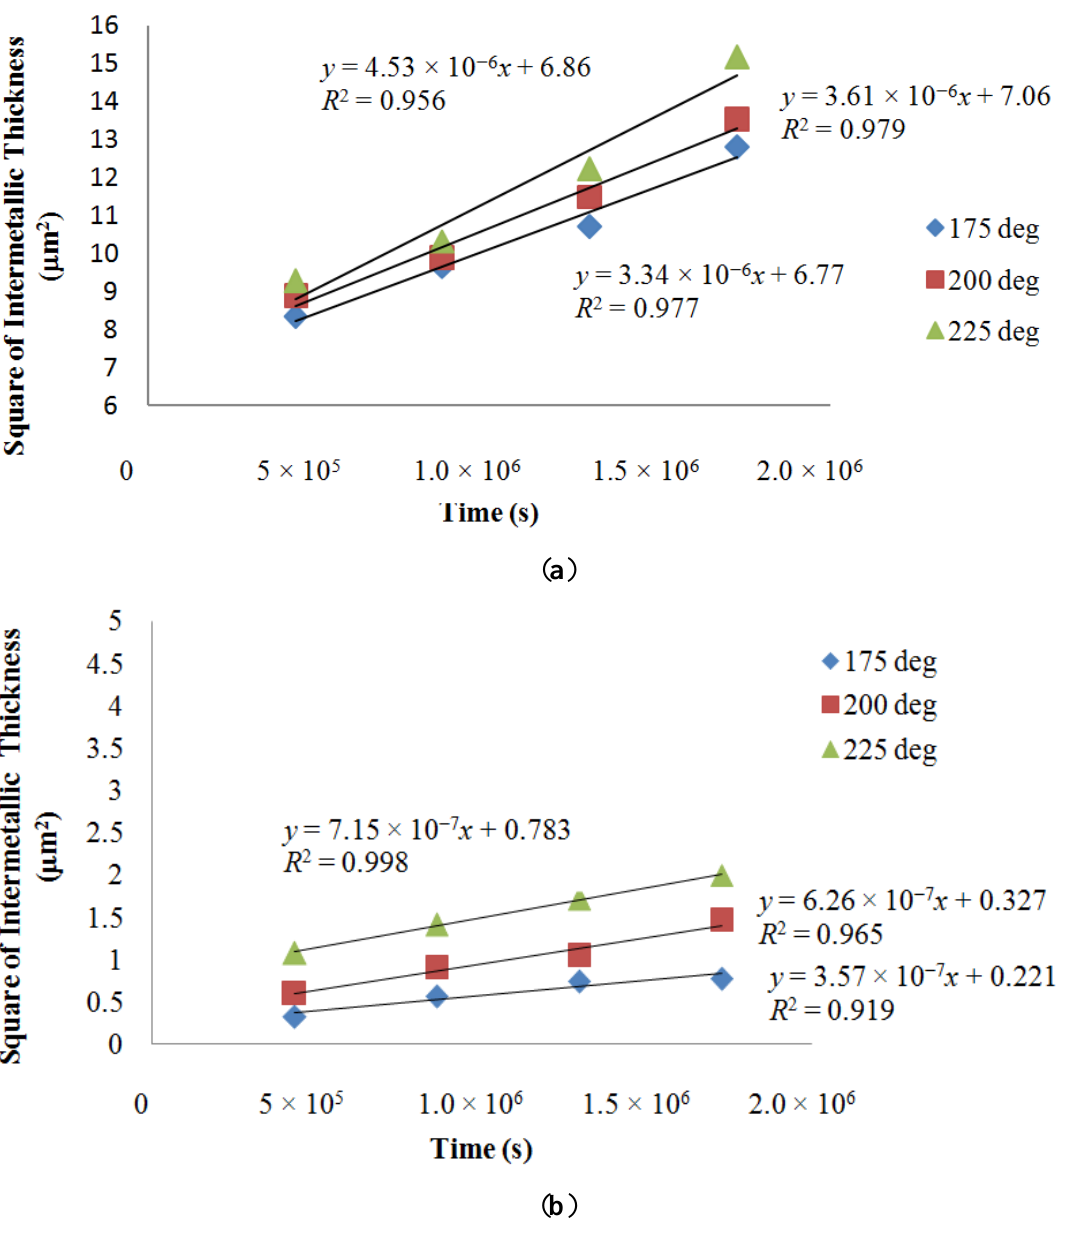
Figure 10. Intermetallic growth rates (K) at three different temperatures for ( a ) Au and ( b ) Cu wire bonding.